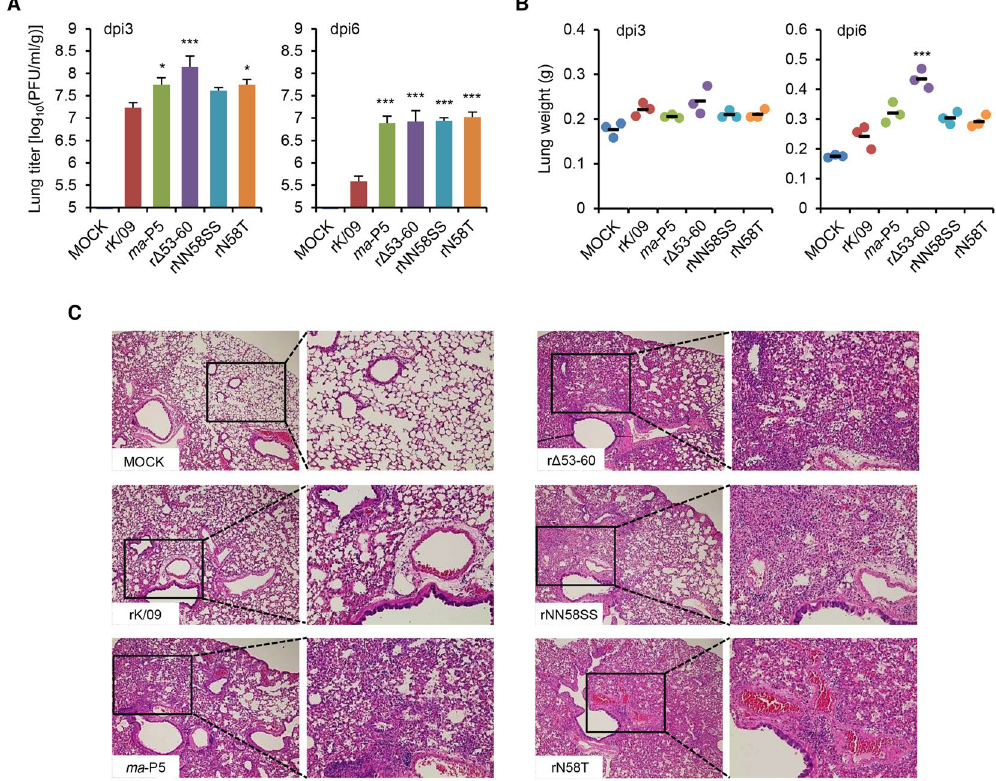
Figure 4. Virus replication and histopathological examination of the lungs of the infected mice. Three mice per group were infected intranasally with 10 5 PFU of each virus and euthanized at 3 and 6 dpi, respectively, for internal body organ collection from the infected mice. Viral titers in the lungs ( A ) and lung weights ( B ) of the infected mice were represented in average. Error bars denote SD ( * P < 0.05 and *** P < 0.001 compared with the rK/09 results). ( C ) Lung histopathology of the mice infected with rK/09, ma -P5, r Δ 53–60, rNN58SS, and rN58T were evaluated using the H&E